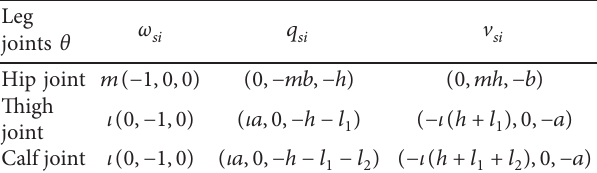
Table 3: The coordinates of the leg joints spiral axis in the body coordinate system.